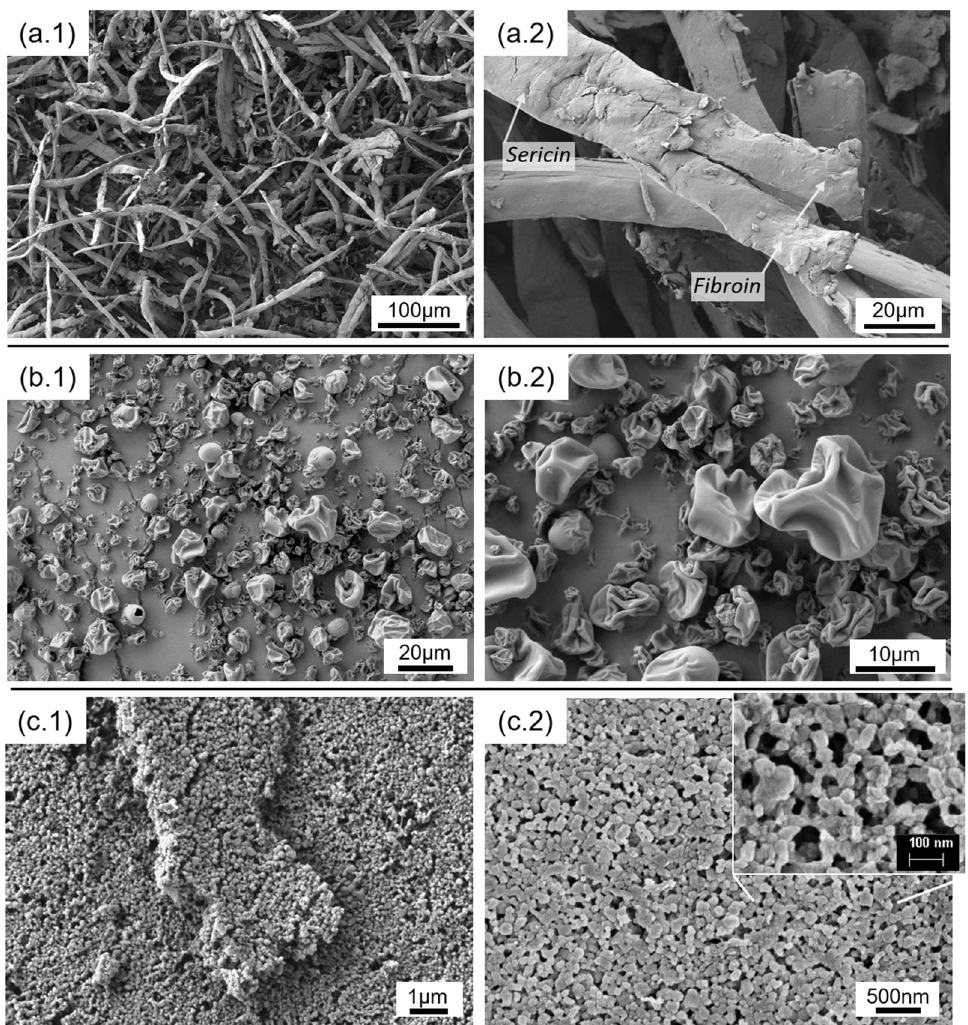
Figure 2. FESEM images of the prepared silk fillers: crushed silk microfibers ( a.1 , a.2 ), sprayed SF microparticles ( b.1 , b.2 ), and SF nanoparticles ( c.1 , c.2 ) at different magnifications.